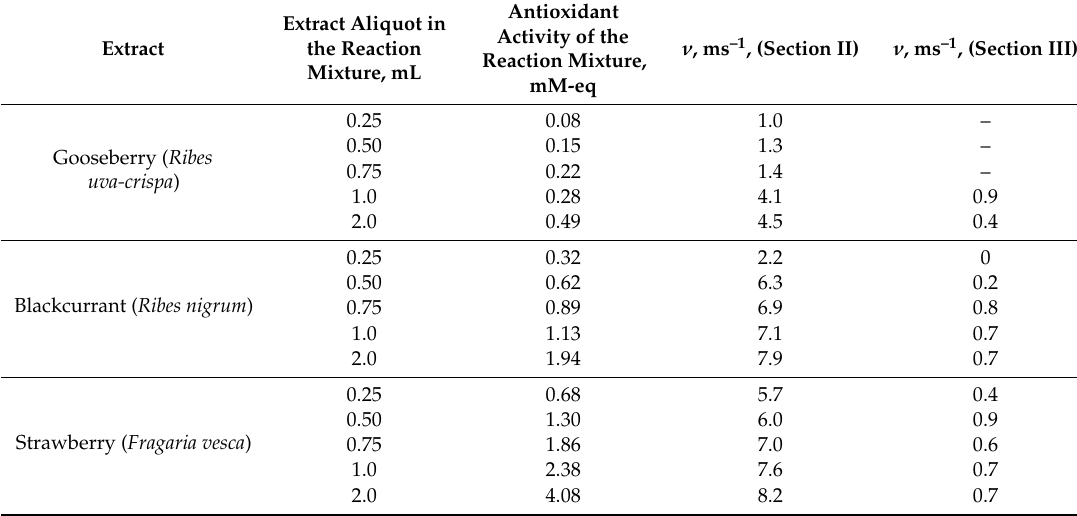
Table 1. Phyto-AuNPs’ suspension formation rates ( ν ~d A max /d t ) calculated for growth (II) and saturation (III) sections of the kinetic curves in Figure 2.